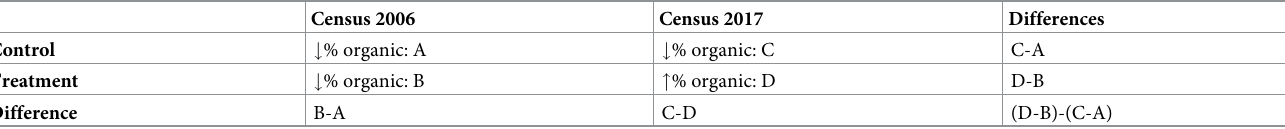
Table 1. Difference-in-differences.